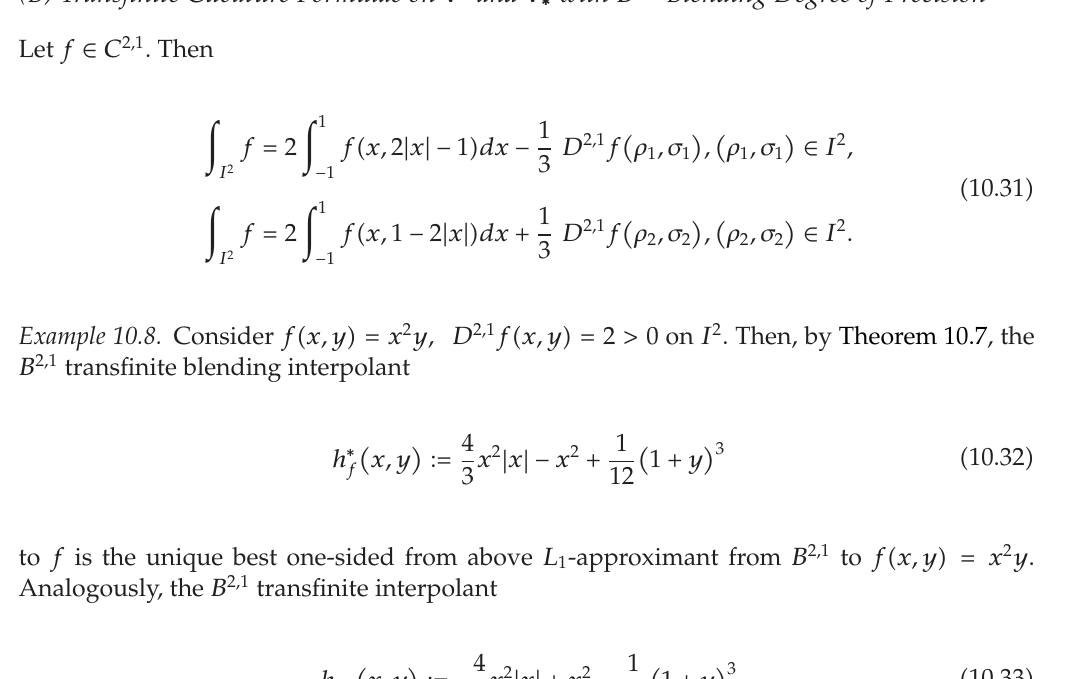
(cid:3) x,y (cid:4) f